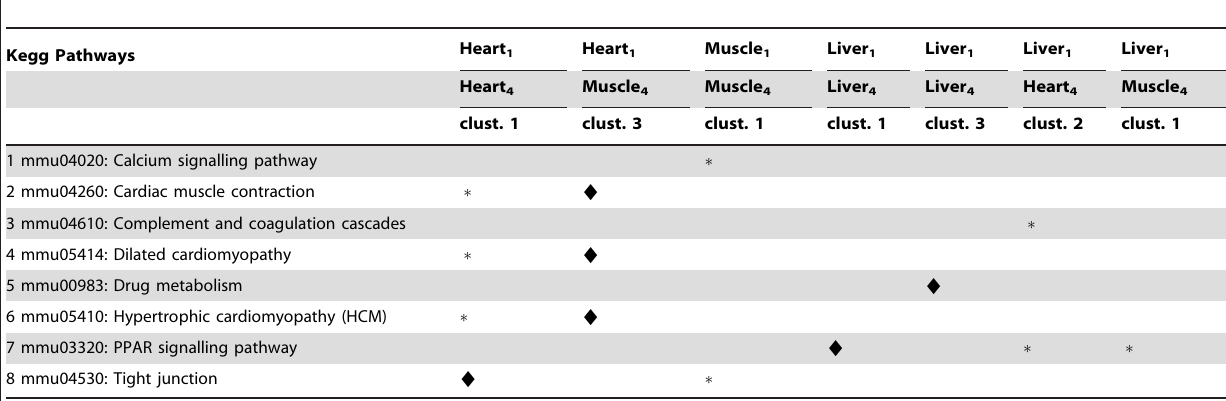
Table 6. Enrichment of KEGG pathways in the common genes between the clusters found by the two ways of factorization.